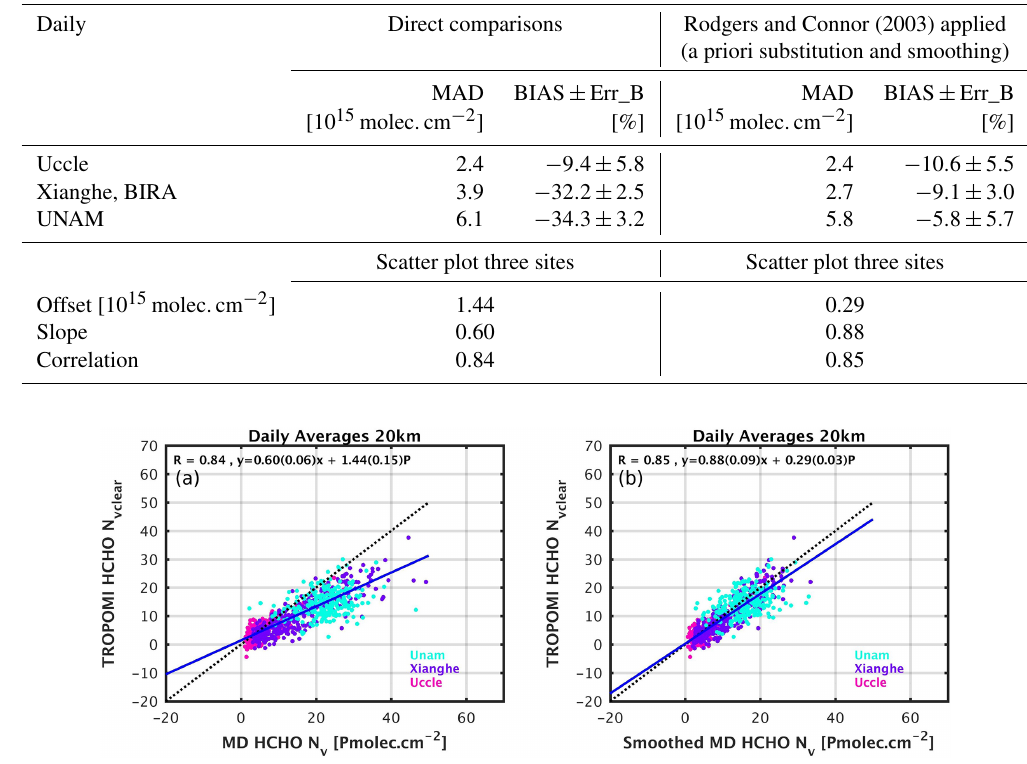
Figure 17. Scatter plots of TROPOMI versus MAX-DOAS data for the daily means of collocated data before (a) and after (b) verti- cal smoothing of the MAX-DOAS profile in Uccle, Xianghe and UNAM, Mexico. The correlation, slope and intercept of a linear re- gression using the robust Theil–Sen estimator is given in each panel and plotted as a blue line. The black dotted line is the 1:1 line (Pmolec.cm − 2 = 10 15 molec.cm − 2 ).